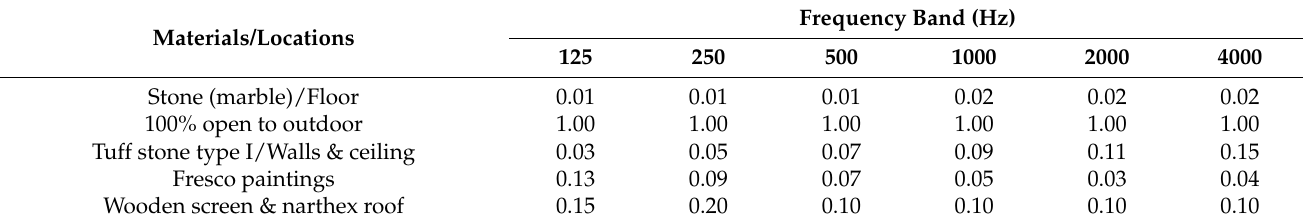
Table 5. Absorption coefficients ( α ) over 1/1 octave bands of the materials applied to Bell Church acoustical model.